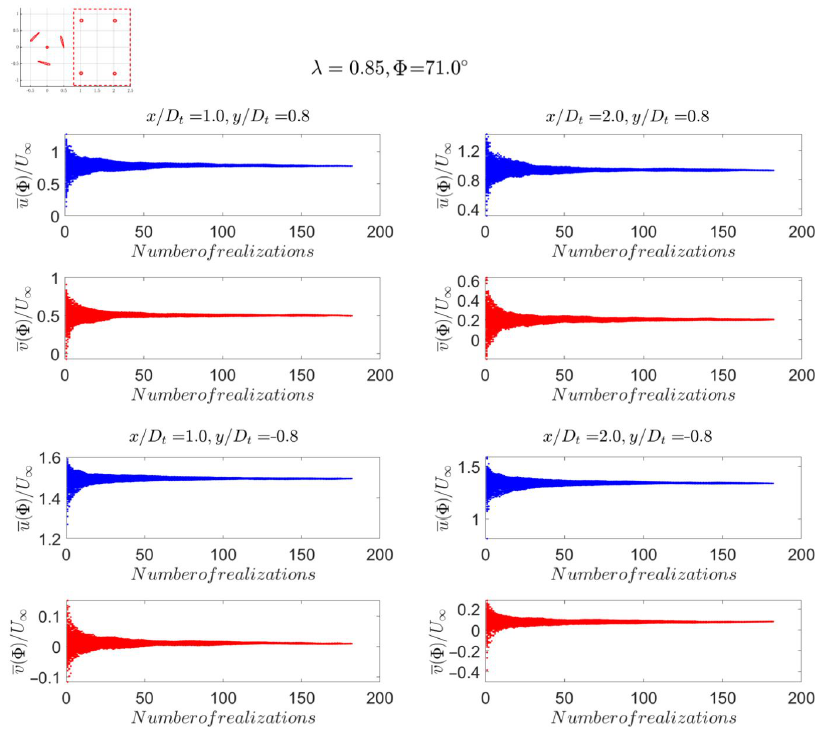
Figure 9. An example of the flow converged over more than 100 phases of the T1 configuration at λ = 0.85 and at Φ = 71 ◦ . The vertical axes are the streamwise and transverse velocities, at the 4 points highlighted in Figure 5, averaged over time.